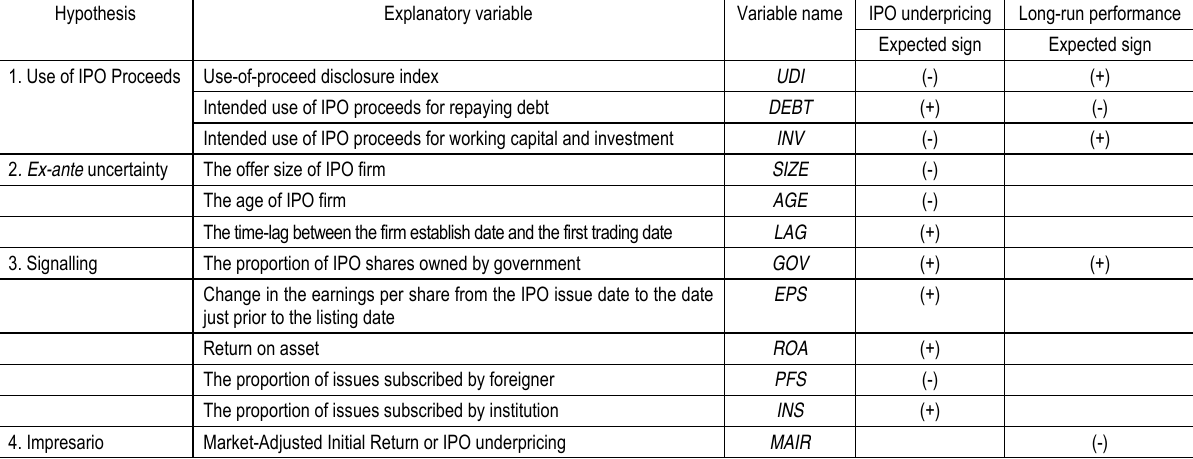
Table 1. Testable Hypotheses to Explain Underpricing and Long-run Performance